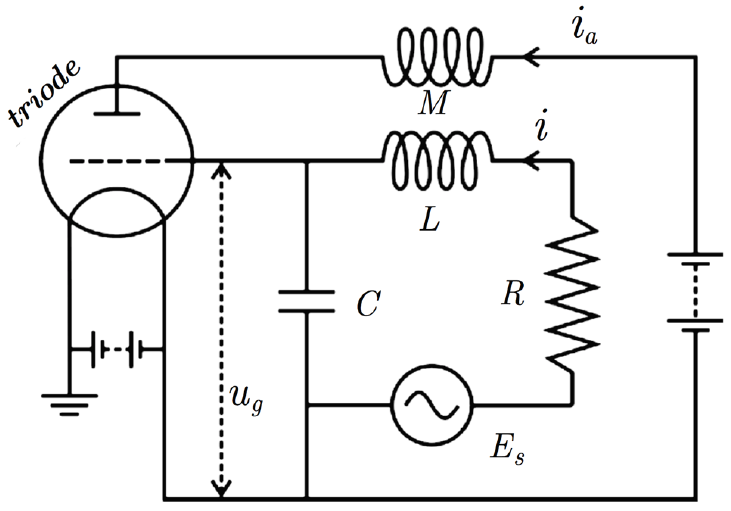
Figure 5. Electrical circuit involving a triode, resulting in a forced van der Pol